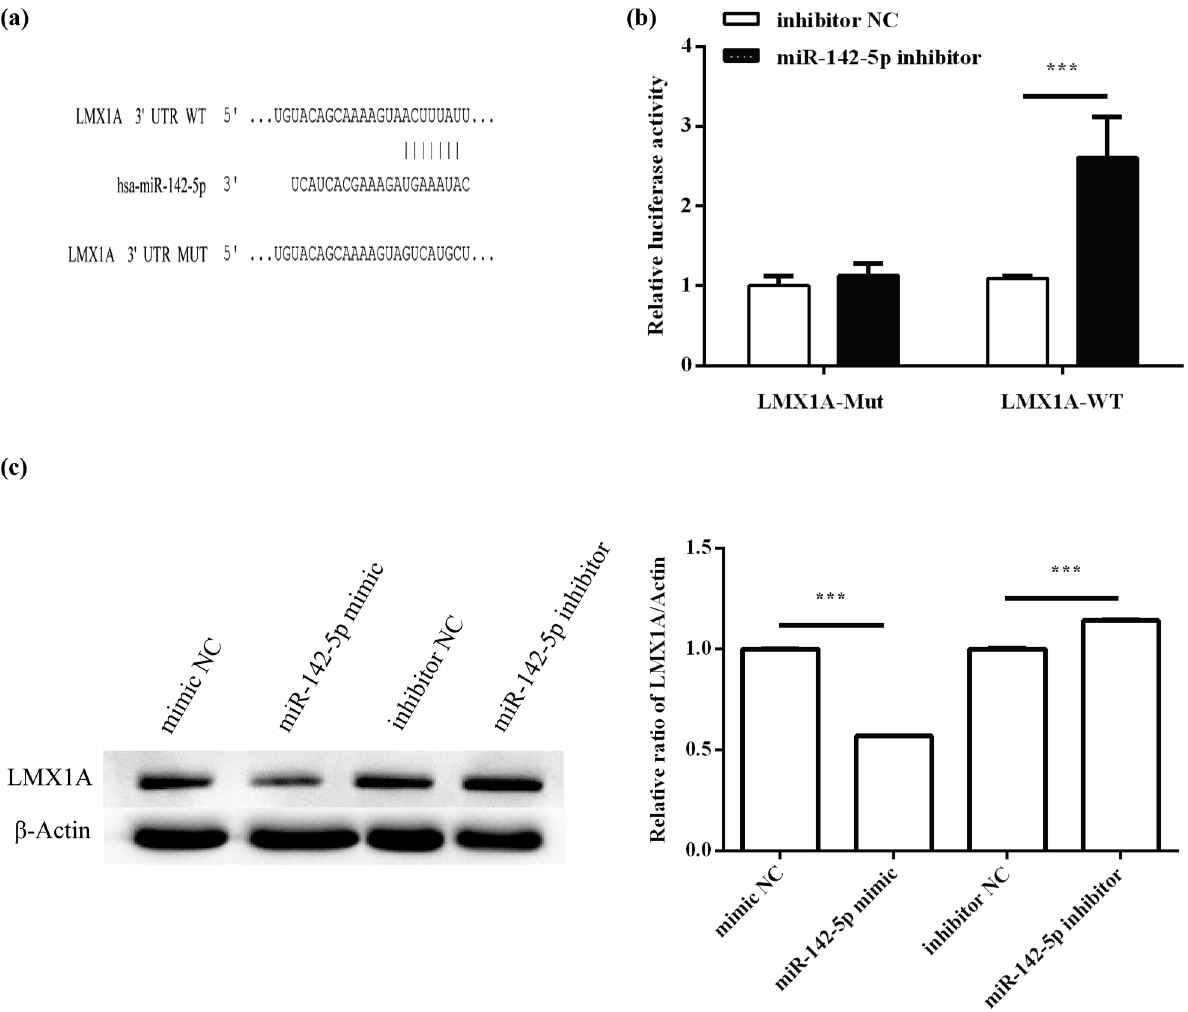
Figure 4: LMX1A is a target of miR - 142 - 5p. a The binding site of LMX1A for miR ‑ 142 ‑ 5p was predicted by TargetScan tool. ( a ) Binding sites for miR - 142 - 5p in the 3 ′ - UTR of LMX1A mRNA. ( b ) Luciferase reporter assay showing reduced luciferase reporter activity in HeLa cells containing the LMX1A - WT 3 ′ - UTR fragment. ( c ) Western blotting analysis of expression of LMX1A protein in HeLa cells. All experiments were performed in triplicate. *** P <